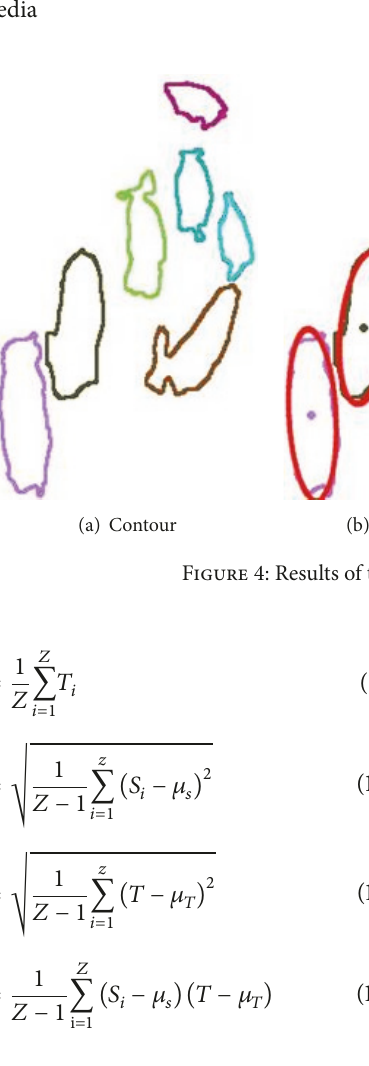
Figure 5: The structural similarity of different segmentation algo-